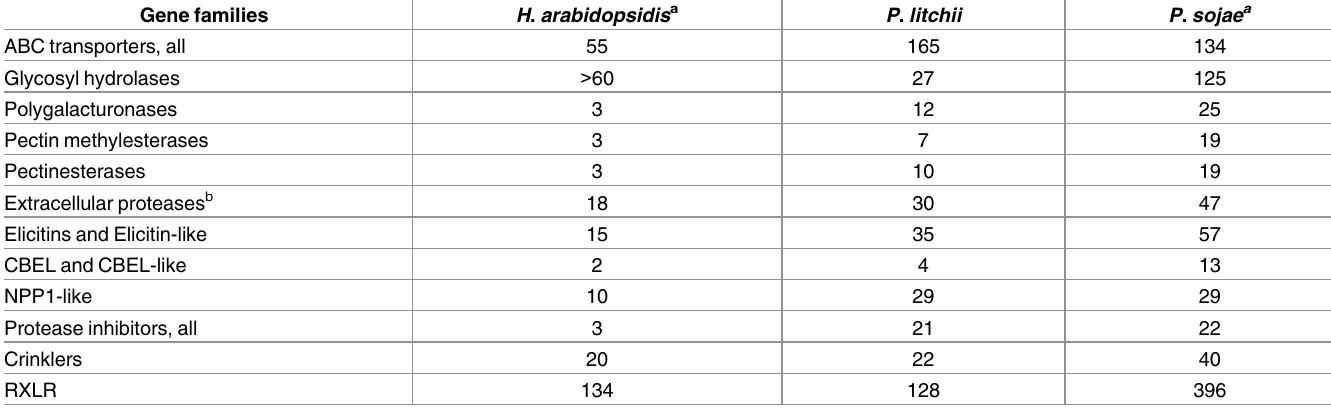
Table 3. Gene families of P . litchii potentially implicated in plant